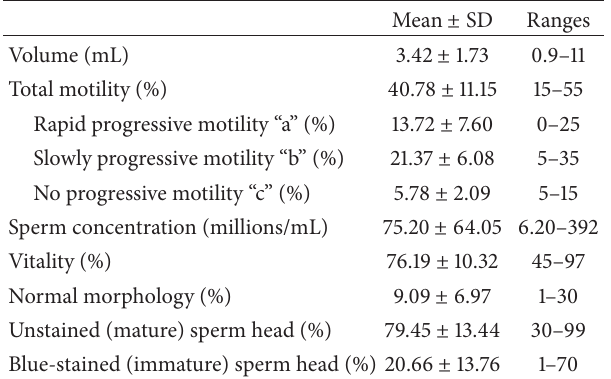
Table 1: Means and ranges of semen parameters and AB tingibility of sperm nuclear in the study samples ( 𝑛 = 51 ). Mean ± SD Ranges Volume (mL) 3.42 ± 1.73